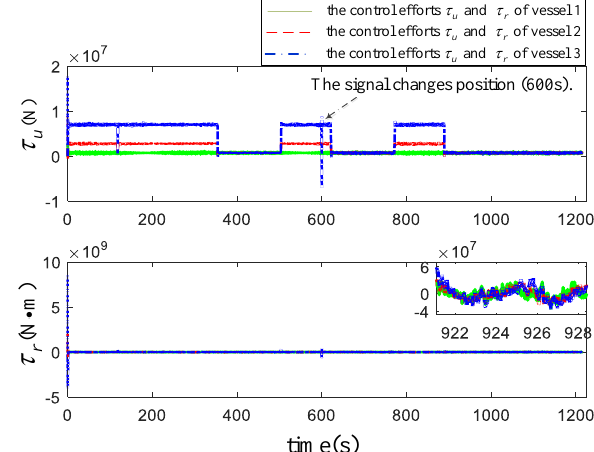
Figure 8. The changes in adaptive laws